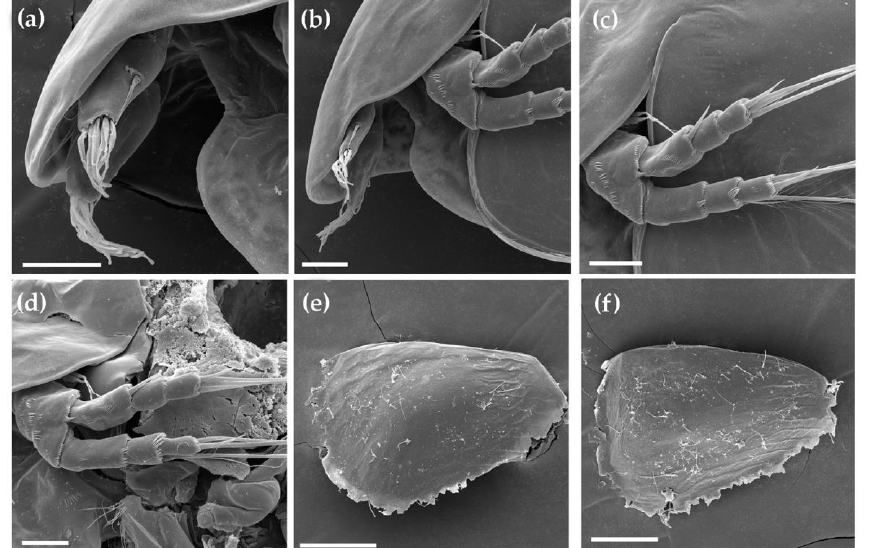
Figure 20. Coronatella anemae , an adult parthenogenetic female and ephippia from Wadi Maidaq—Blue Pool, United Arab Emirates. ( a , b ) Antenna I; ( c , d ) antenna II; ( e , f ) ephippium, lateral view. Scale bars: 0.1 mm for ( e , f ), 0.02 mm for ( a – d ). Parthenogenetic female. Body colourless, in lateral view ovoid (Figures 17a and 18a), with a regularly curved dorsal margin and rounded posterodorsal angle. Ventral margin rather straight in anterior half to slightly concave in posterior portion (Figure 17a), posteroventral corner with an unclear notch. In dorsal and ventral view, body rela- tively strongly compressed, but lacking a pronounced keel (Figure 18e). Head small. Ocellus as almost large as eye (Figure 17a). Head shield broad, with rounded posterior margin (Figure 18e). Rostrum blunt and short, aesthetascs projecting beyond its tip (Figures 17a and 20a,b). Three major head pores of same size, narrowly connected; lateral pores minute (Figure 18f,g). Labral keel in lateral view relatively short, with moderately convex to wavy margin and obtuse tip (Figure 19c). A bunch of fine setulae on labral keel. Valve with ornamentation consisting of parallel, well-developed, wide diagonal lines (Figure 18a,b,h). Posterior margin wavy. This ornamentation less developed on the head shield (Figure 18b,e). Marginal setae in different groups, relatively longer group on frontal margin of valve, followed by somewhat shorter group in middle and medi- um-sized group in posterior third of the margin (Figures 18i and 19a,b). Postabdomen relatively long, about 2.5 – 3 times long as wide, in general subovoid (Figures 17b,c, 18c and 19d,e). Preanal, anal and postanal margins of similar length (postanal portion may be slightly longer than anal margin). Ventral margin as long as anal and postanal margin, ending abruptly before preanal corner. Postanal margin al- most straight, tapering distally, distal margin protruding. Preanal corner strongly de- veloped, triangular, protruding beyond anal and postanal margins. Marginal denticles well-developed, arranged in 8 – 10 groups. These marginal denticles may be relatively long (Figure 19e,f) or shorter (Figure 17c). Distal postanal marginal denticles consisting of two or more large spines, those closer to the anal margin in groups of three to four long spines, of which distal element largest. Lateral fascicles form five to seven groups in postanal portion, consisting of over 15 slender spinules in each group, parallel to each